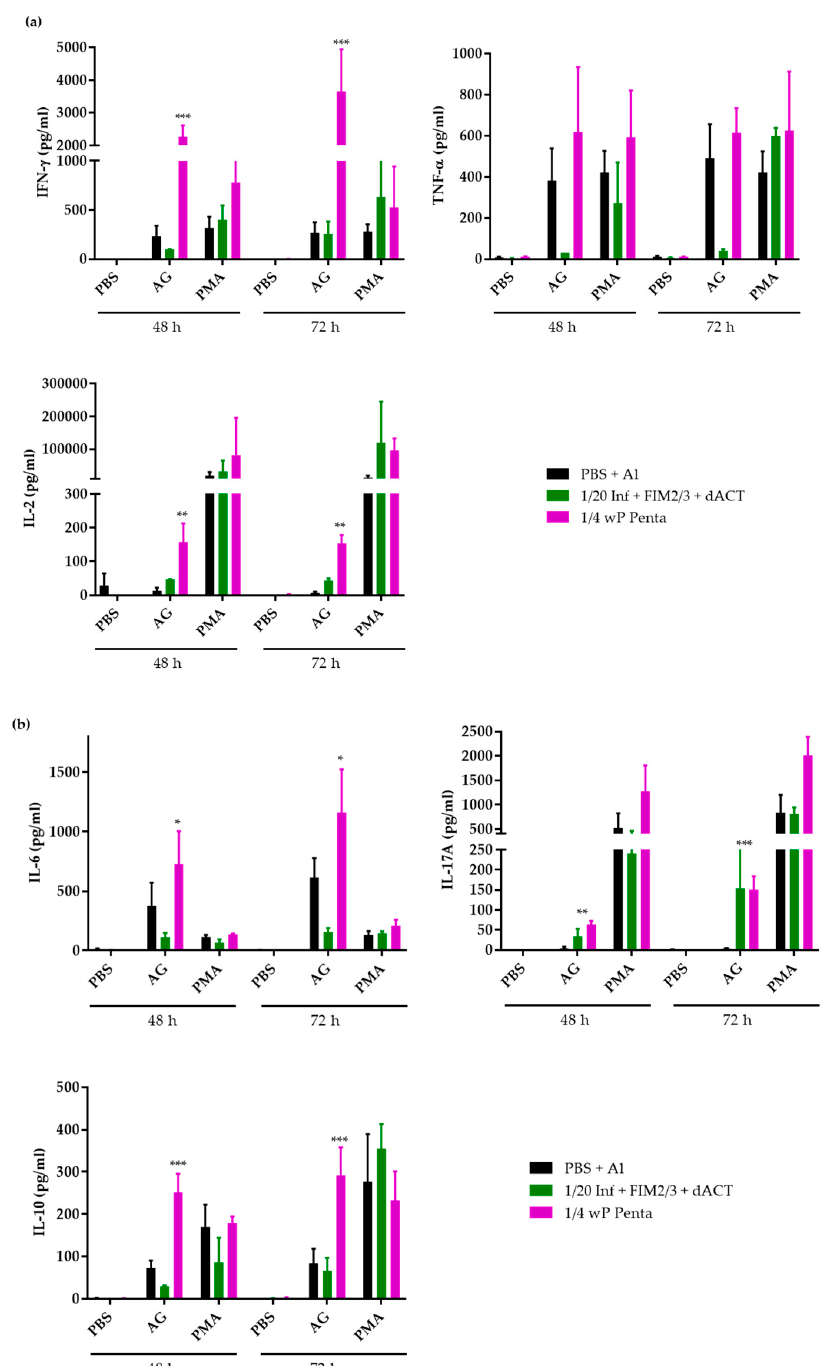
Figure 5. Cytokine secretion by restimulated splenocytes of BALB/c mice immunized by 1/20 HD of antigen-supplemented Infanrix ® aP vaccine. ( a ) Th1 cytokines. ( b ) IL-6, Il-17A and IL-10 cytokines. Splenocytes from four mice per time point were restimulated for 48 or 72 h using the antigen combinations used for immunizations (AG = mixture of all antigens used for immunizations). Two supernatants per time point were pooled and cytokine concentrations were measured in duplicates using a cytokine bead assay, as described in detail in the Materials and Methods. Sham stimulation with PBS and unspecific polyclonal stimulation with phorbol myristate acetate (PMA) plus ionomycin were used as negative and positive control, respectively. Data shown as mean ± SD. * ( p < 0.05); ** ( p < 0.01); *** ( p < 0.001) vs. negative control mice.